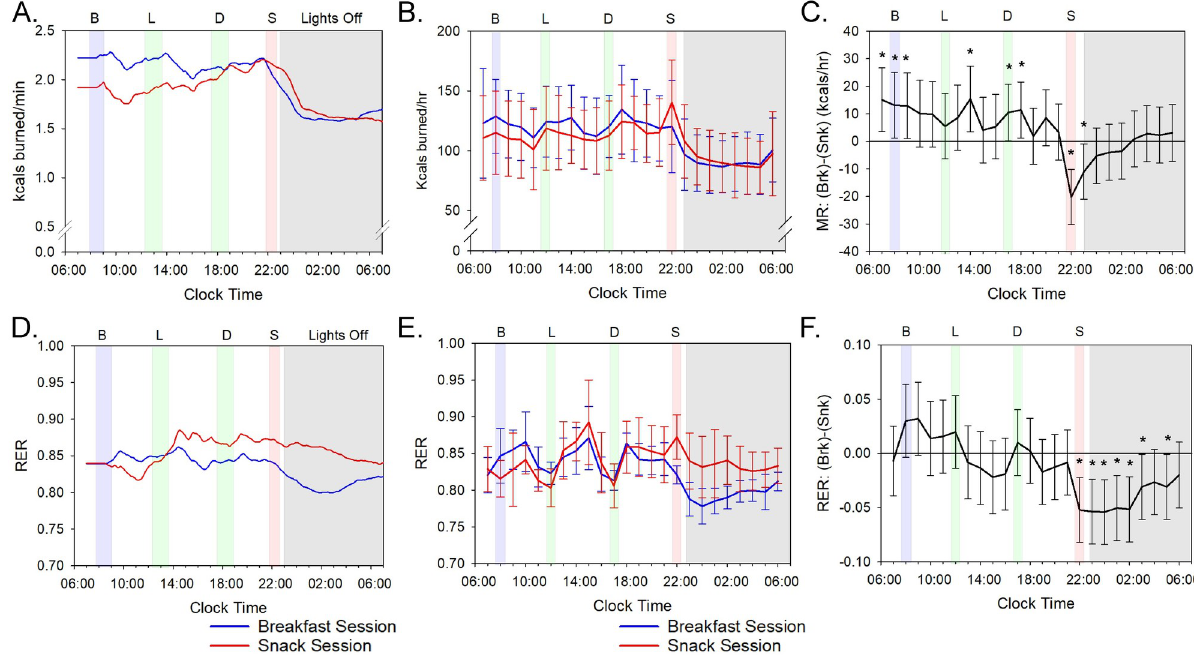
Fig 2. MRs and RER values. See S3 and S4 Figs and S2A and S2D Table for underlying data and analyses. (A) MR by indirect calorimetry for a representative participant (Subject #3). The data for Subject #3 are plotted as a moving average using 180 data points (= 3 h) after aligning all time points to clock time and integrated on a 24-h scale. (B) Average MR for all subjects plotted modulo-24 h. Data were averaged into 1-h bins with error bars indicating standard deviation. See S4 Fig for data of all subjects’ MRs individually plotted. (C) Average hourly pairwise comparison of (breakfast − snack) MR values for all subjects. Error bars indicate 95% confidence intervals and values are based on a mixed-model analysis. Asterisks indicate significant differences ( p -value < 0.05) between breakfast and snack values for the indicated 1-h bins. See S2D Table for the hour-by-hour statistical comparison of the Breakfast versus the Snack Sessions. (D) RER (VCO 2 /VO 2 ) by indirect calorimetry of a representative individual (subject #3). The data for Subject #3 are plotted as a moving average using 180 data points (= 3 h) after aligning all time points to clock time and integrated on a 24-h scale. (E) Average RER for all subjects plotted modulo-24 h. Data were averaged into 1-h bins with error bars indicating standard deviation. See S3 Fig for data of all subjects’ RER individually plotted. (F) Average hourly pairwise comparison of (breakfast − snack) RER values for all subjects. Error bars indicate 95% confidence intervals, and values are based on a mixed-model analysis. Asterisks indicate significant differences ( p -value < 0.05) between breakfast and snack values for the indicated 1-h bins. See S2A Table for the hour-by-hour statistical comparison of the Breakfast versus the Snack Sessions and S3 Table for a statistical comparison of peak/trough amplitude. All panels: the blue line indicates values during the subjects’ Breakfast Sessions and the red line for the subjects’ Snack Sessions. Shading indicates meals and lights off as in Fig 1B and 1C. Error bars indicate ± standard deviation. MR, metabolic rate; RER, respiratory exchange